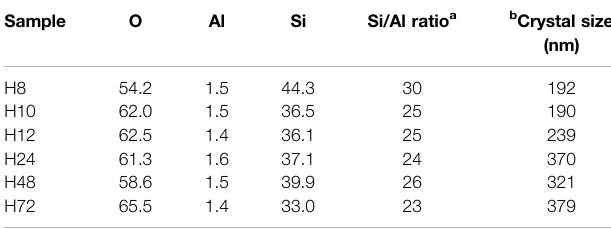
TABLE1| ElementalcompositionandcrystalsizeofHBEAzeolitesobtainedusing SEM-EDS.